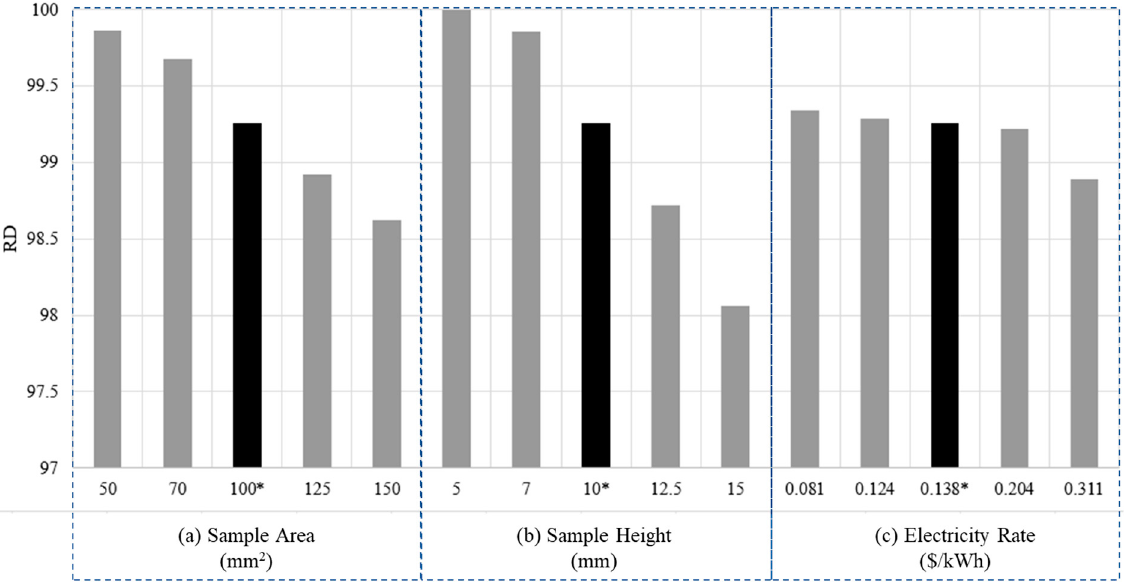
Figure 4. Sensitivity analysis of relative density with change in ( a ) sample area, ( b ) sample height, and ( c ) electricity rate, using Model 1.